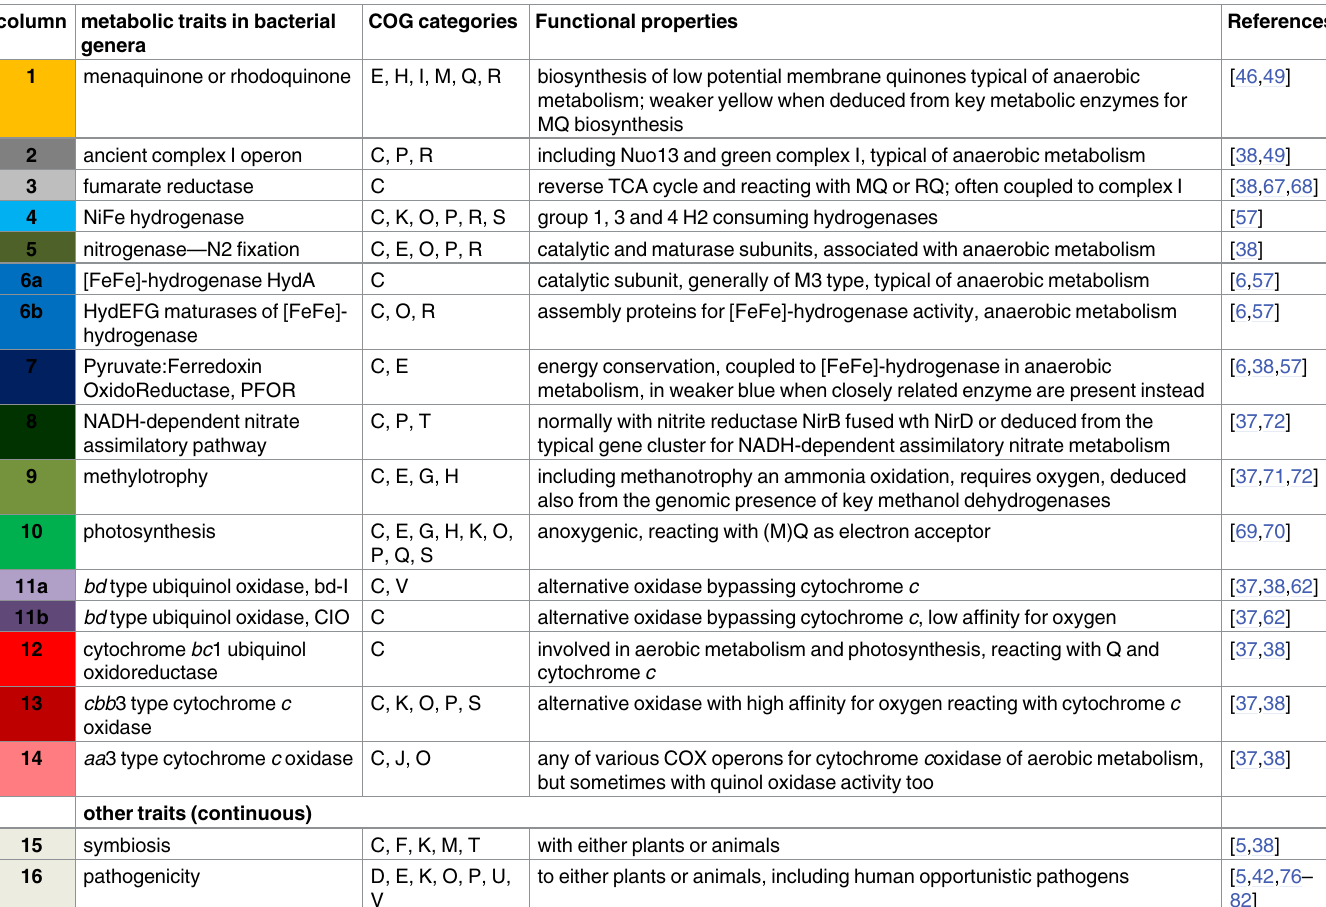
Table 2. The table lists the metabolic traits considered in this work for the functional profile of microbiomes. column metabolic traits in bacterial